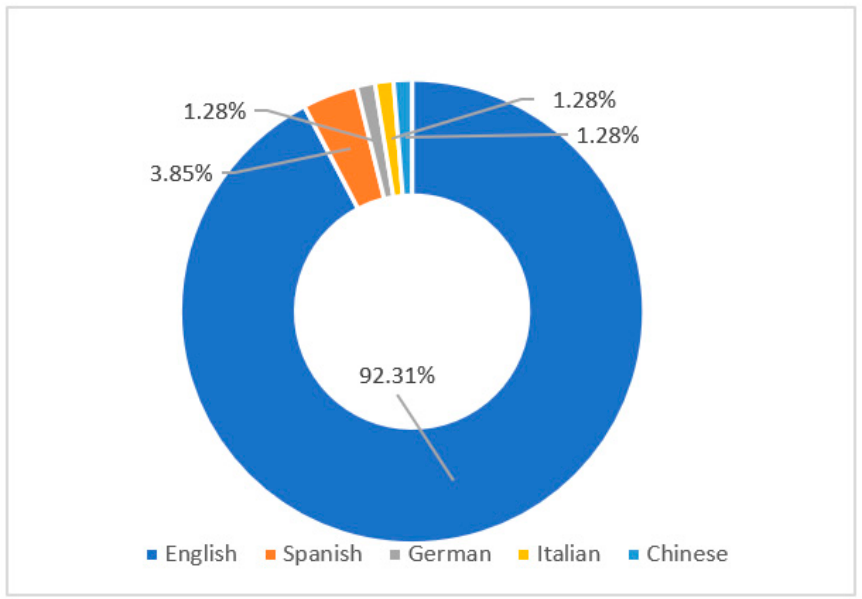
Figure 5. The targeted L2s.